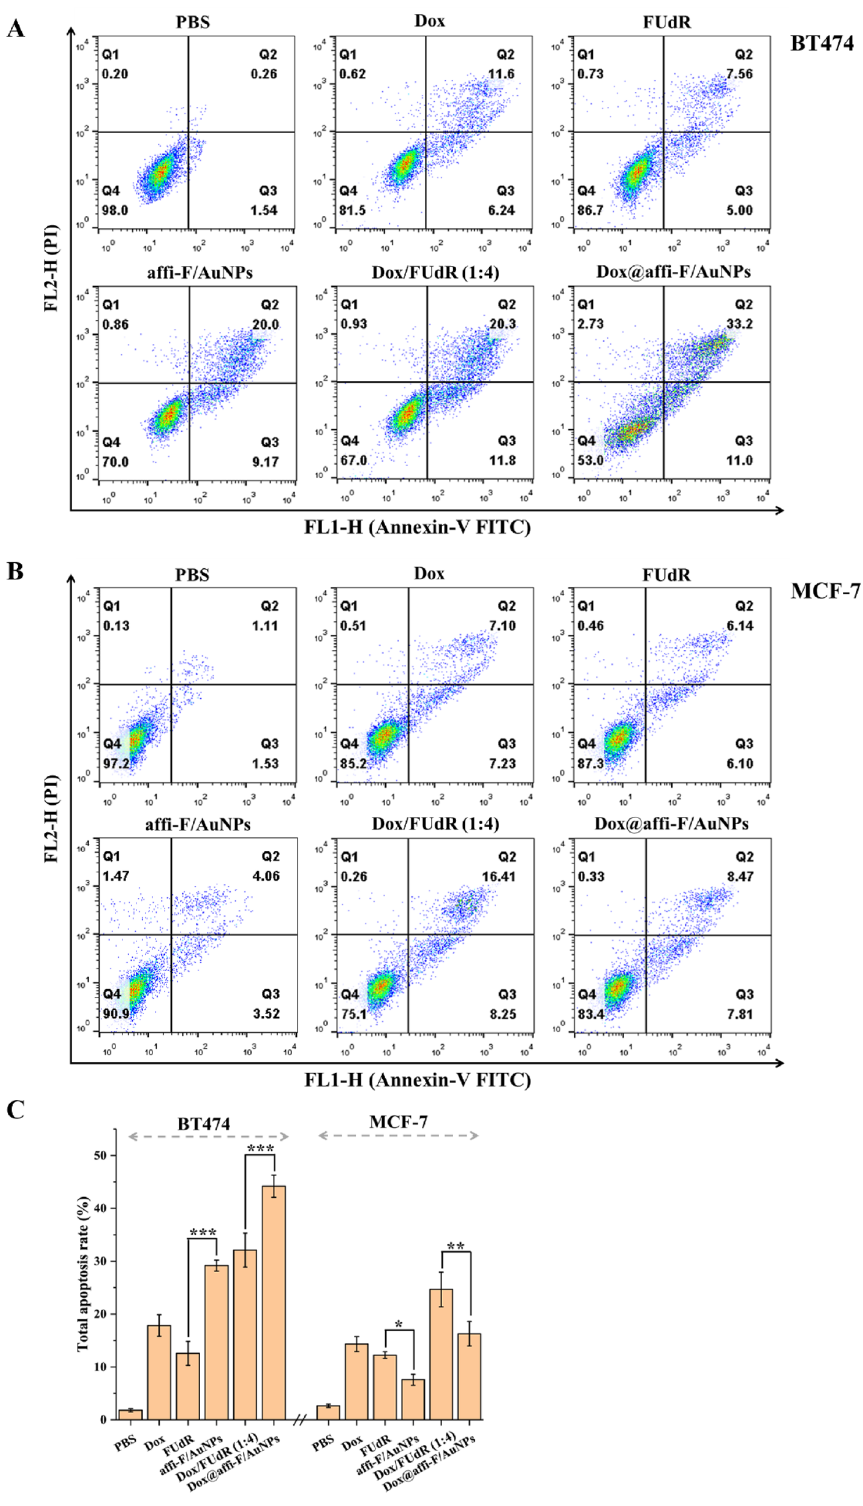
Figure 9. Cell apoptosis assay using flow cytometry. ( A , B ) Flow cytometry scatterplots of apoptosis rate in BT474 and MCF-7 cells. ( C ) Quantitative analysis of the total apoptosis rate in above